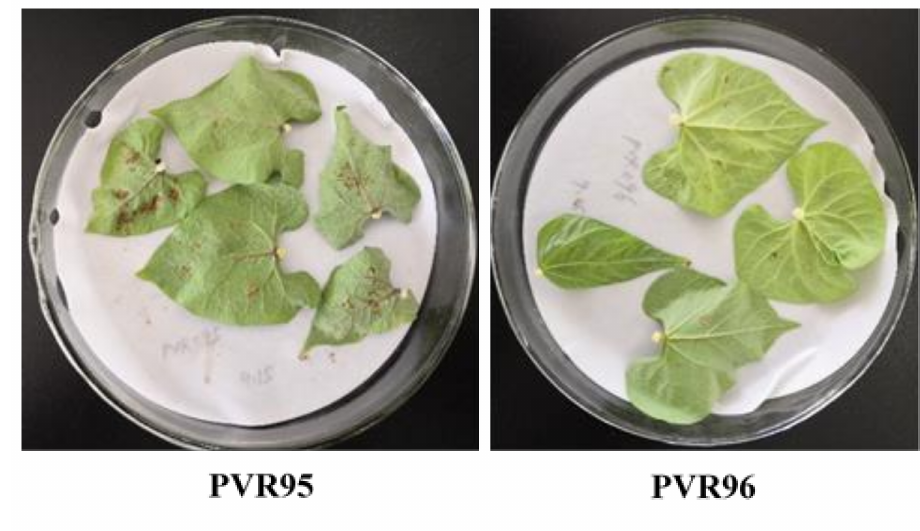
Figure 1. Rust symptoms of the two parents in the RIL population.